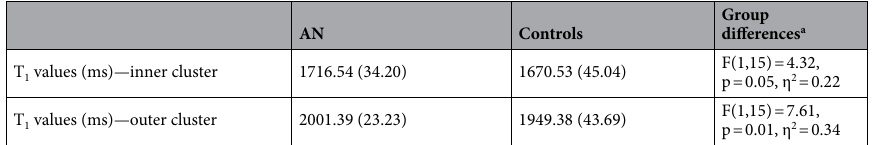
Table 3. T 1 values in the inner and outer cluster across individuals with AN and controls: Analysis of Covariance. Mean (standard deviation) of average T 1 values across cortical depth-levels 1–5 (inner cluster) and 6–10 (outer cluster). Group differences in terms of F value (degrees of freedom), p value and effect size are shown. a Analyses corrected for age.